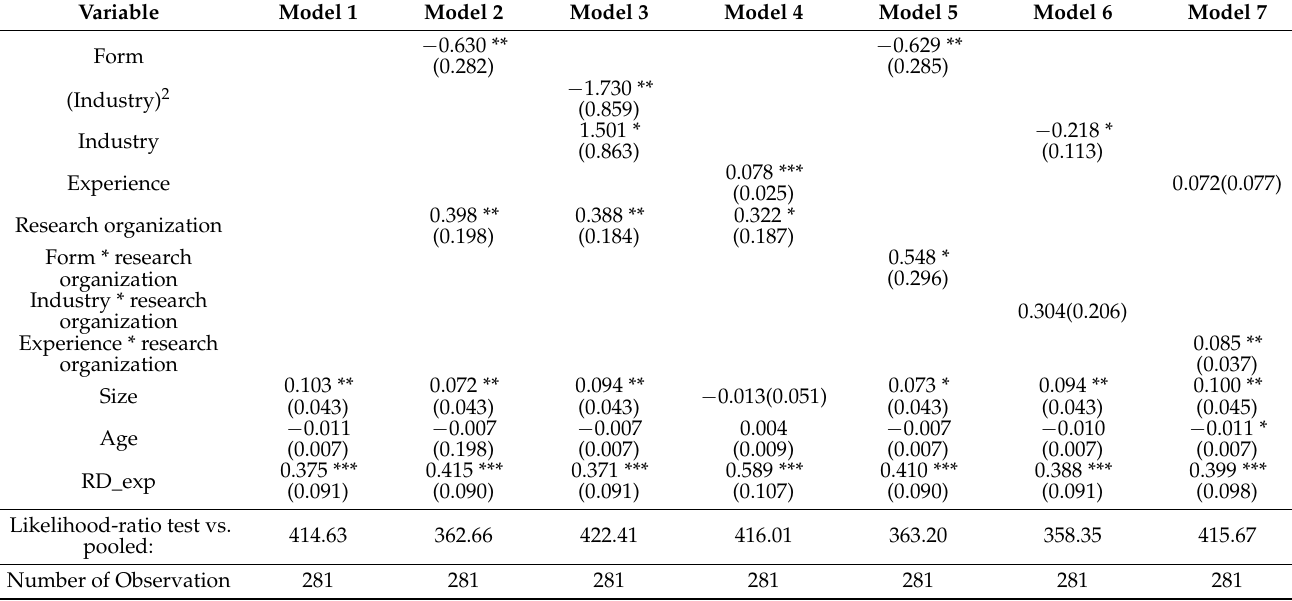
Table 4. Results of negative binomial